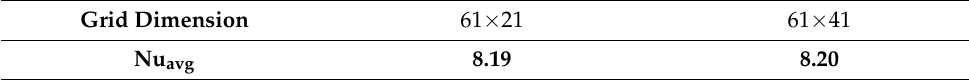
Table 4. Average Nusselt number for a tube fully filled with porous medium in Da = 10 − 3 . Grid Dimension